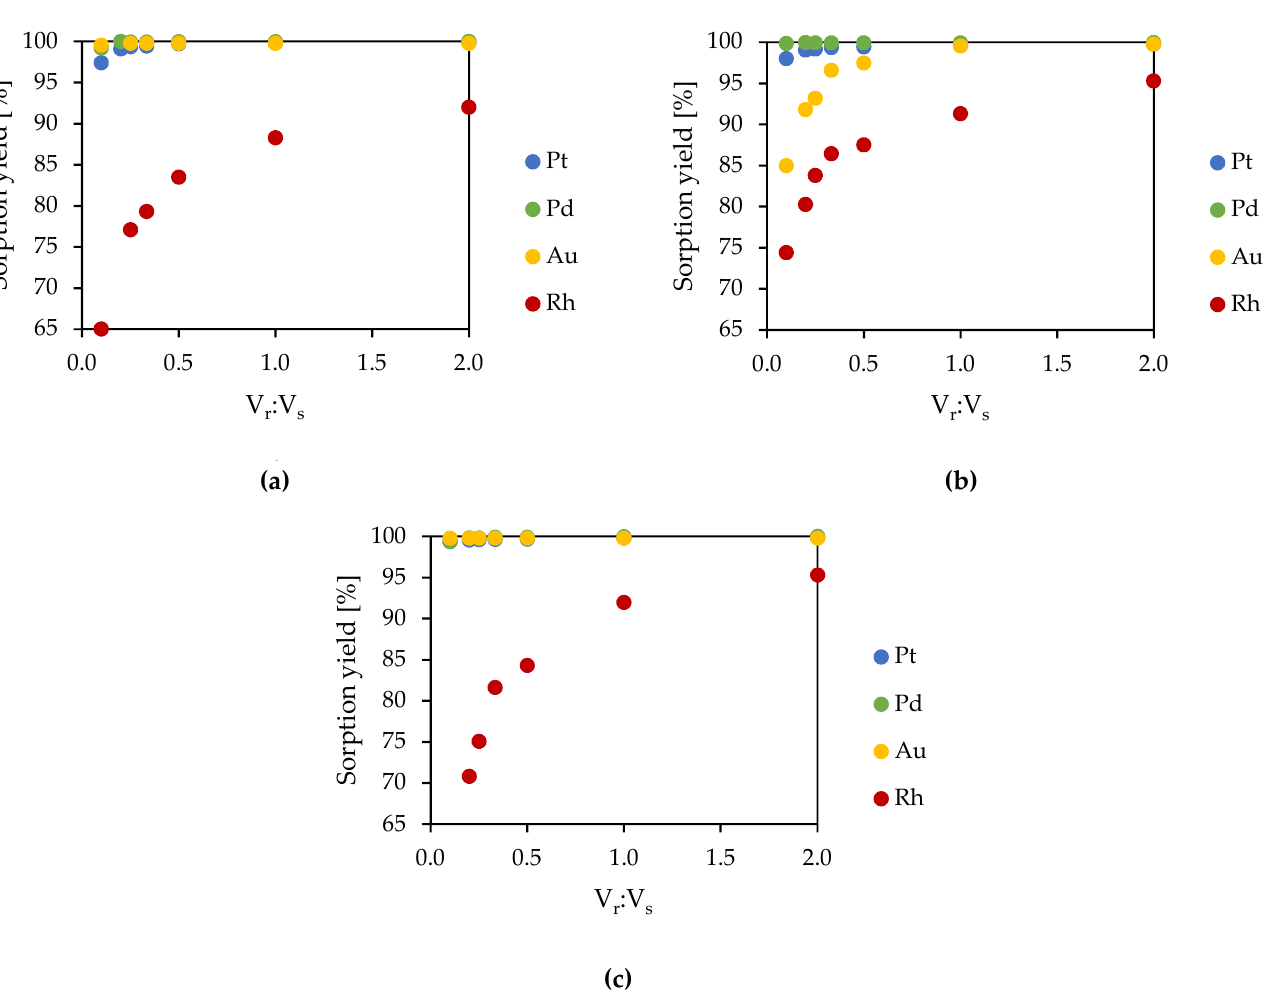
Figure 2. Sorption yields of the individual noble metals in relation to the volume ratio of the phases used in the experiments (V r :V s ): ( a ) Puromet MTS9200, ( b ) Puromet MTS9850, and ( c ) Lewatit K 6362.